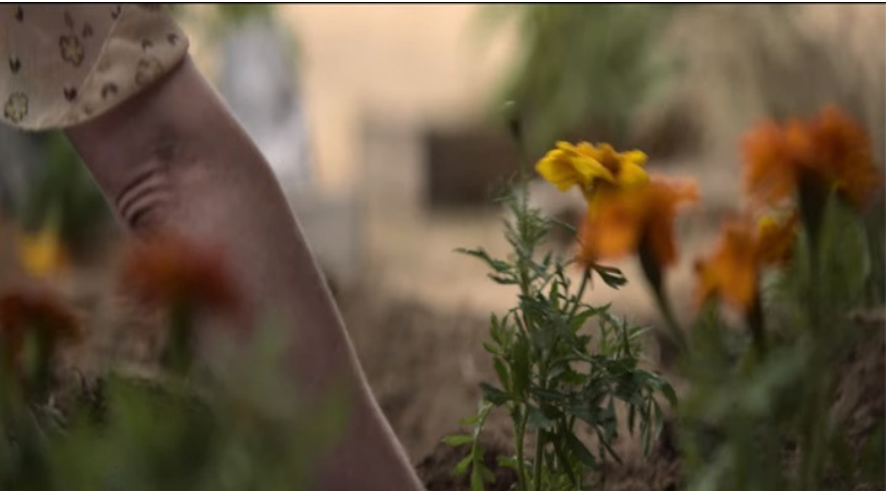
Figure 16. The Power of the Dog . Netflix.